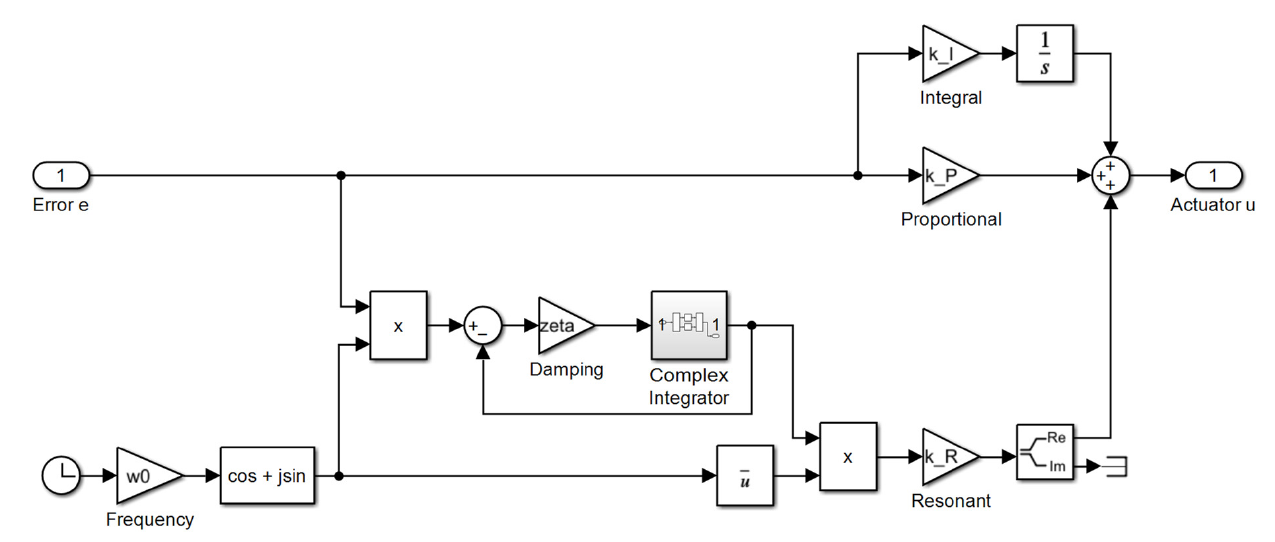
Figure 4. A Modulating Integral Controller.